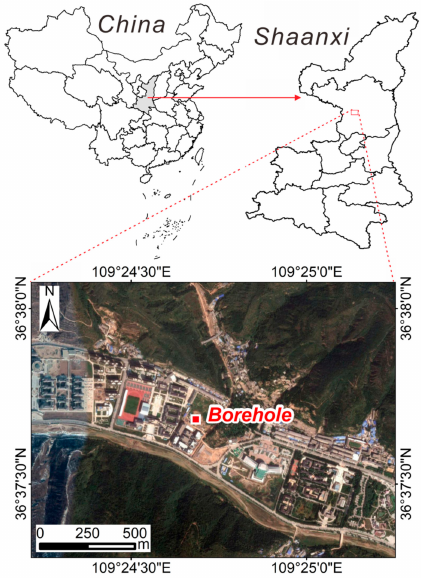
Figure 3. The test site of DPM application in Yan’an city, Shaanxi Province,